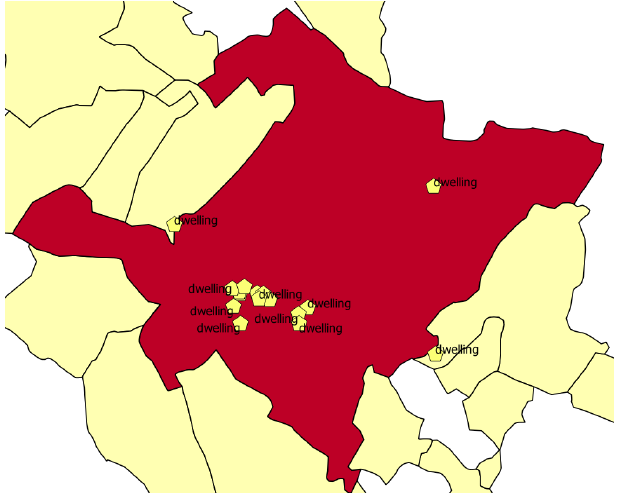
Figure 21. All targets in the municipality of L’Aquila damaged by the earthquake.